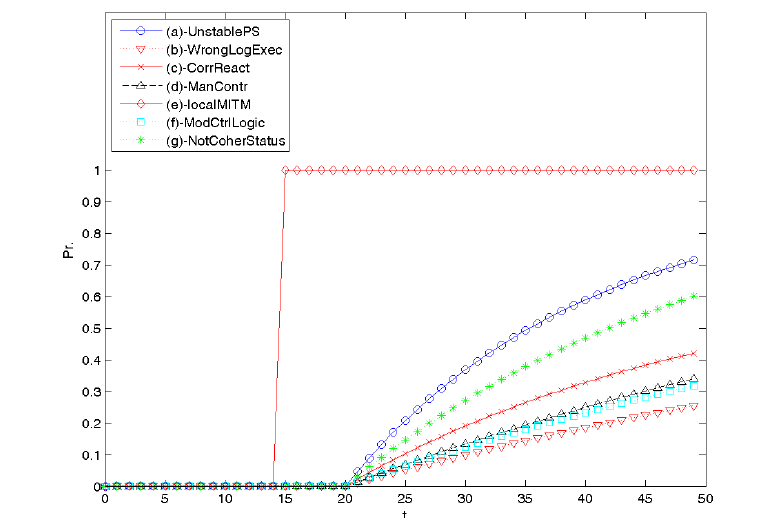
Figure 12. Task: prediction. At time t = 20 on the basis of the observations up to time t , predictions for all subsequent times are computed.